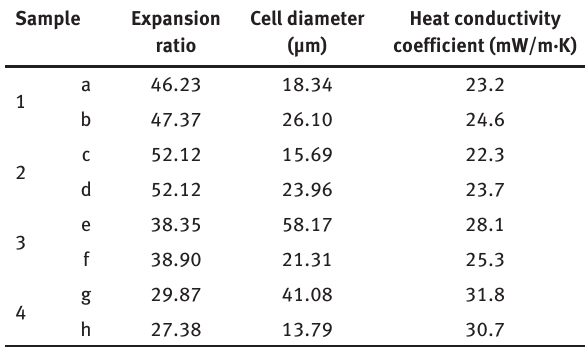
Table 3: Thermal conductivity of the PS-MCF samples in the comparison